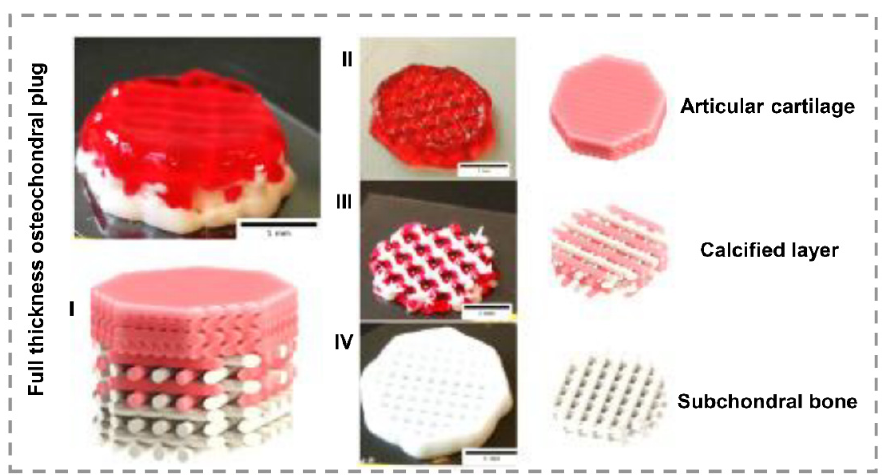
Figure 3. (I) multilayered, 3D-bioprinted scaffold for osteochondral defect. (II) first layer based on alginate ink for articular cartilage regeneration. (III) second layer combination of Alg and CPC for calcified stimulation. (IV) third layer pure CPC for subchondral bone repair. Scale bar illustrates 5mm (reproduced content is open access) [71].